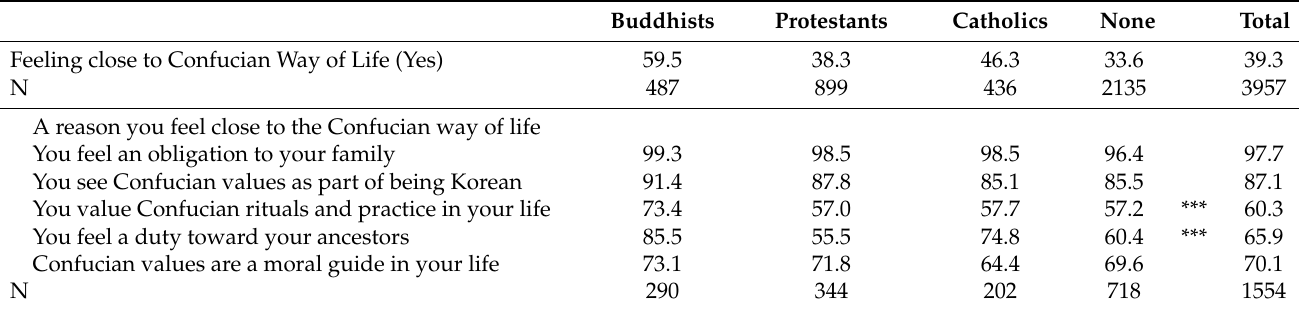
Table 2. Feeling close to the Confucian way of life and reason (%), 2020